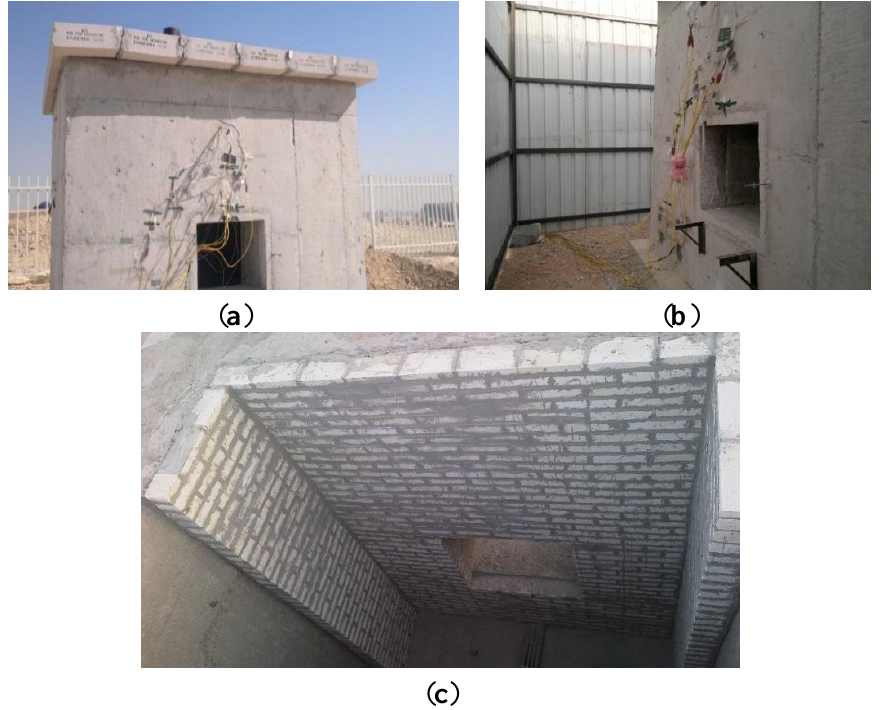
Figure 8. Pictures of the TES bin ( a ) before installing the shield and ( b ) after installing the shield; ( c ) inside picture of the hot